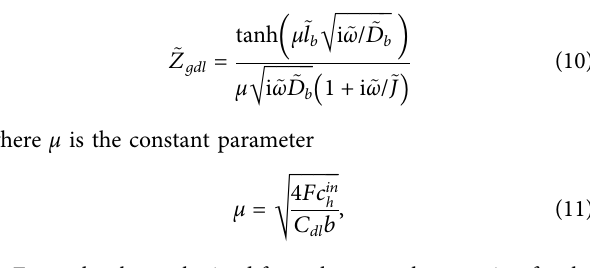
Frontiers in Energy Research |